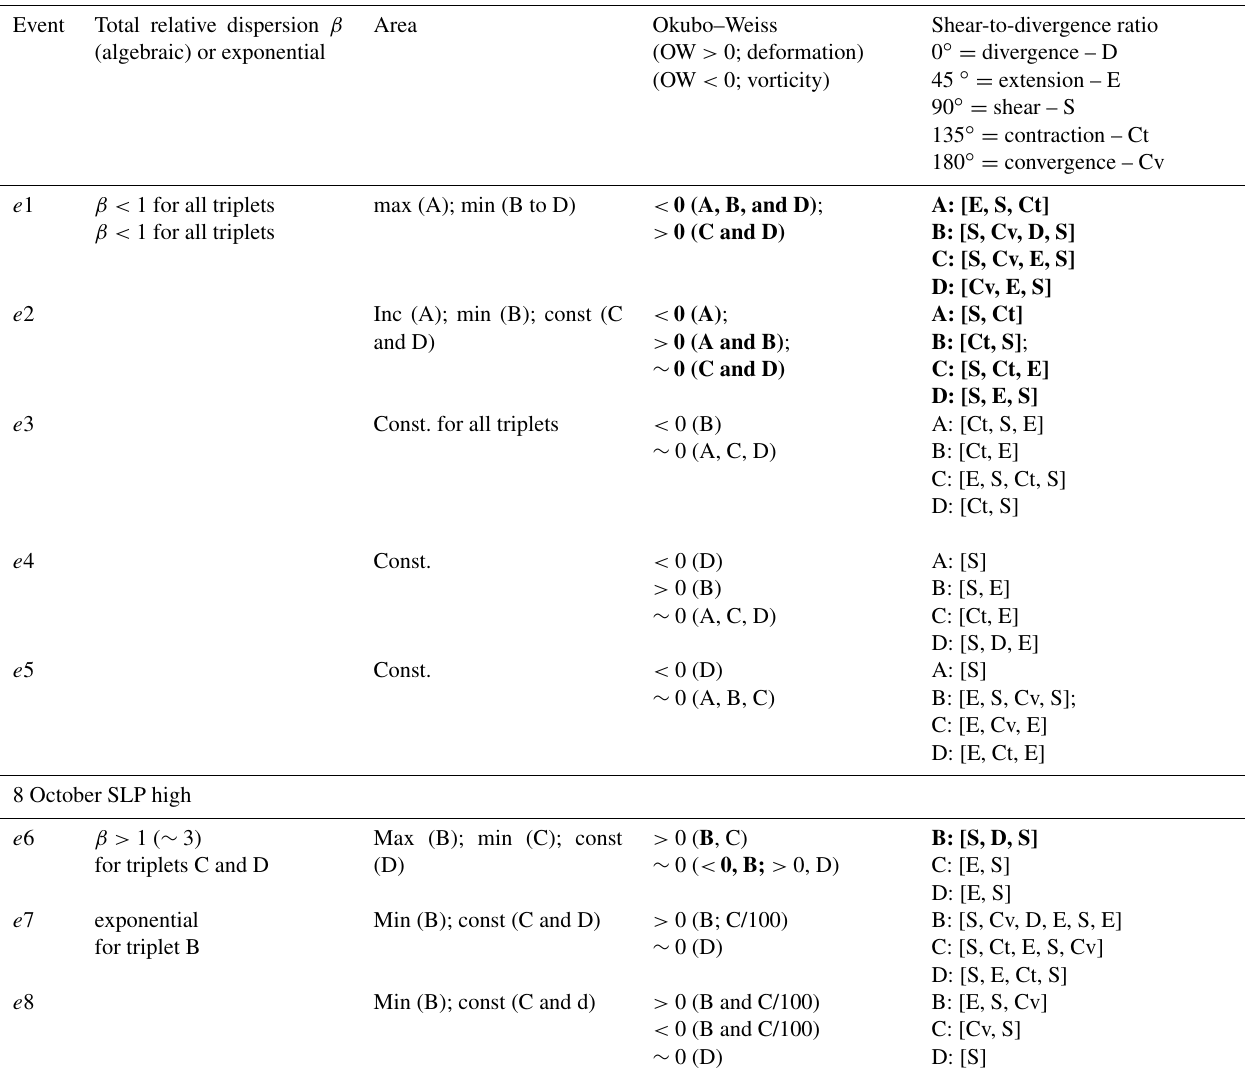
Table 2. Evolution in triplet A to D deformation and differential kinematic parameters (DKPs) ∗ . Shear-to-divergence Event Total relative dispersion β Area Okubo–Weiss (algebraic) or exponential (OW > 0; deformation)